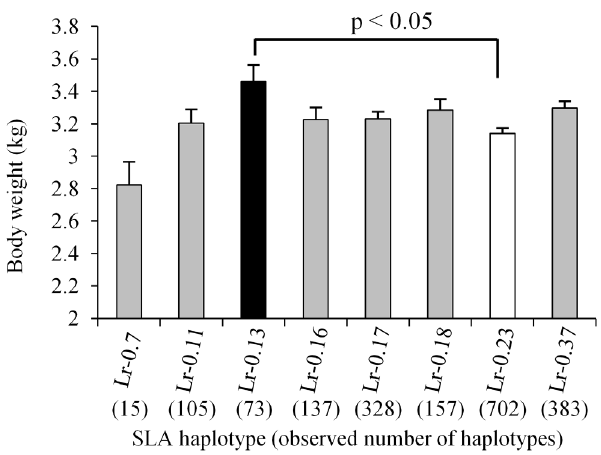
Figure 3. Body weights of piglets with each swine leukocyte antigen (SLA) class II haplotype at 50 days of age. Columns and bars indicate means and standard error, respectively. The number of haplotypes was counted as two in homozygous individuals. The data from Lr-0.7 were excluded from calculations due to the small number of piglets with this haplotype. White and black columns represent the lower and higher mean values of Lr-0.23 and Lr-0.13, respectively, with significant differences among haplotypes. Gray columns represent mean values that did not differ significantly from those of other haplotypes.